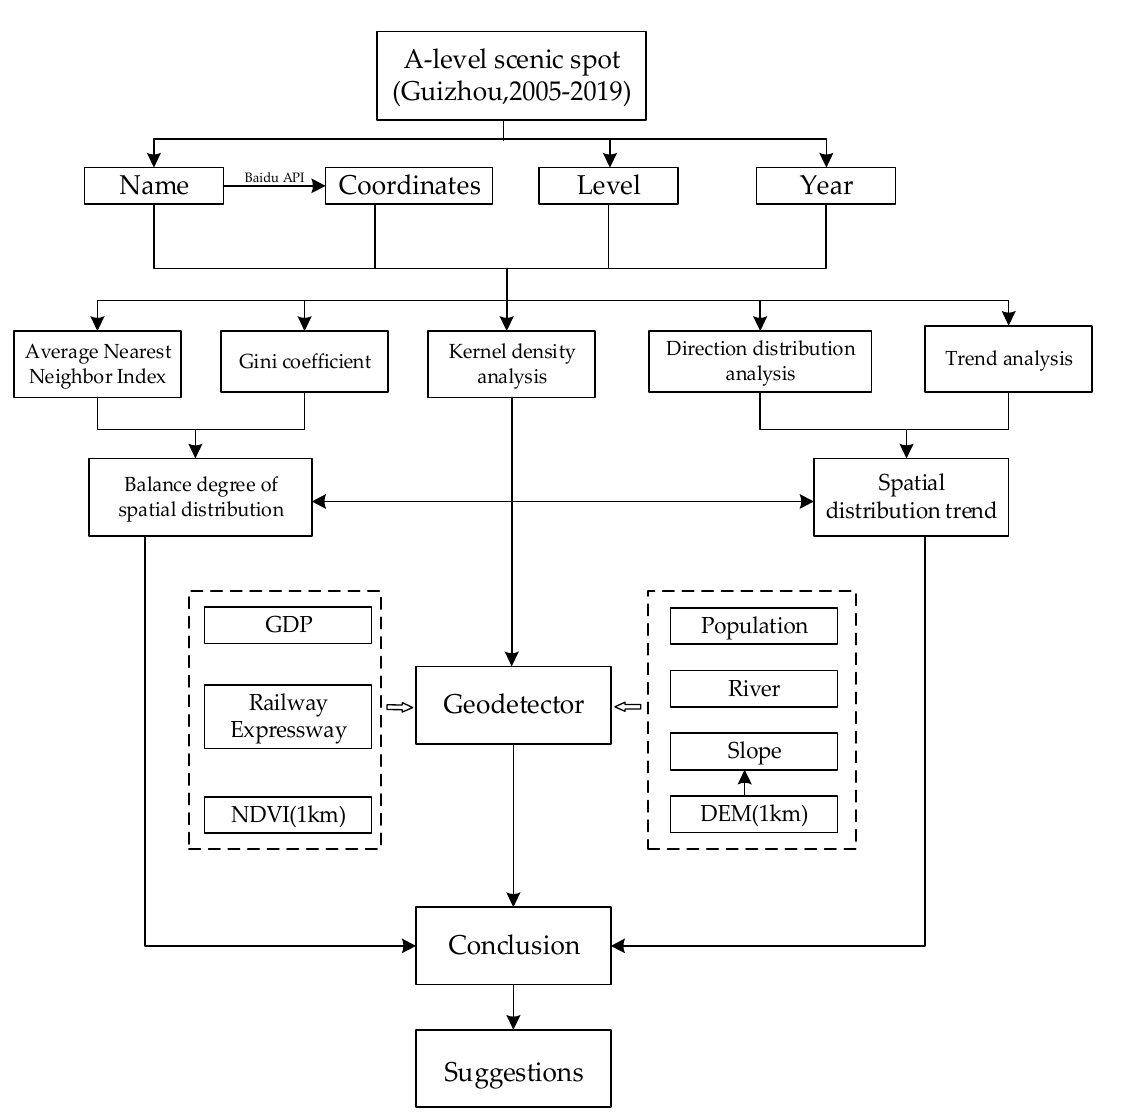
Figure 2. Workflow of the study.